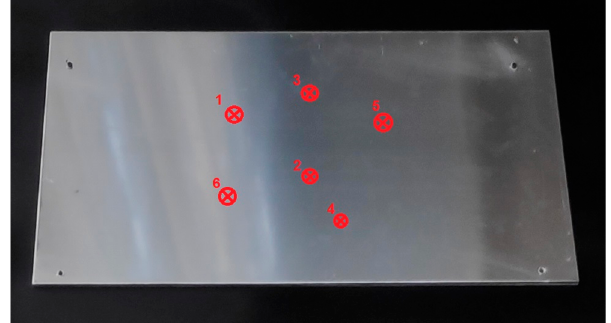
Figure 13. Position of the contacts done during the tests.